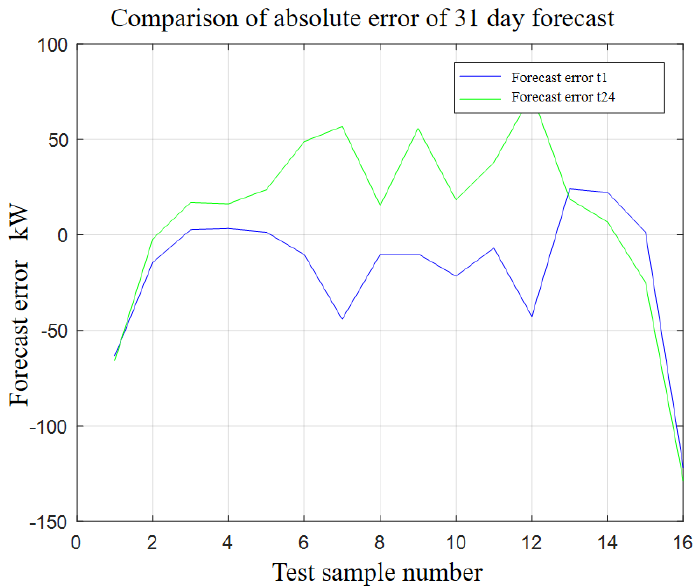
Figure 45. The absolute error plot of the test set of the 1 h ahead prediction.